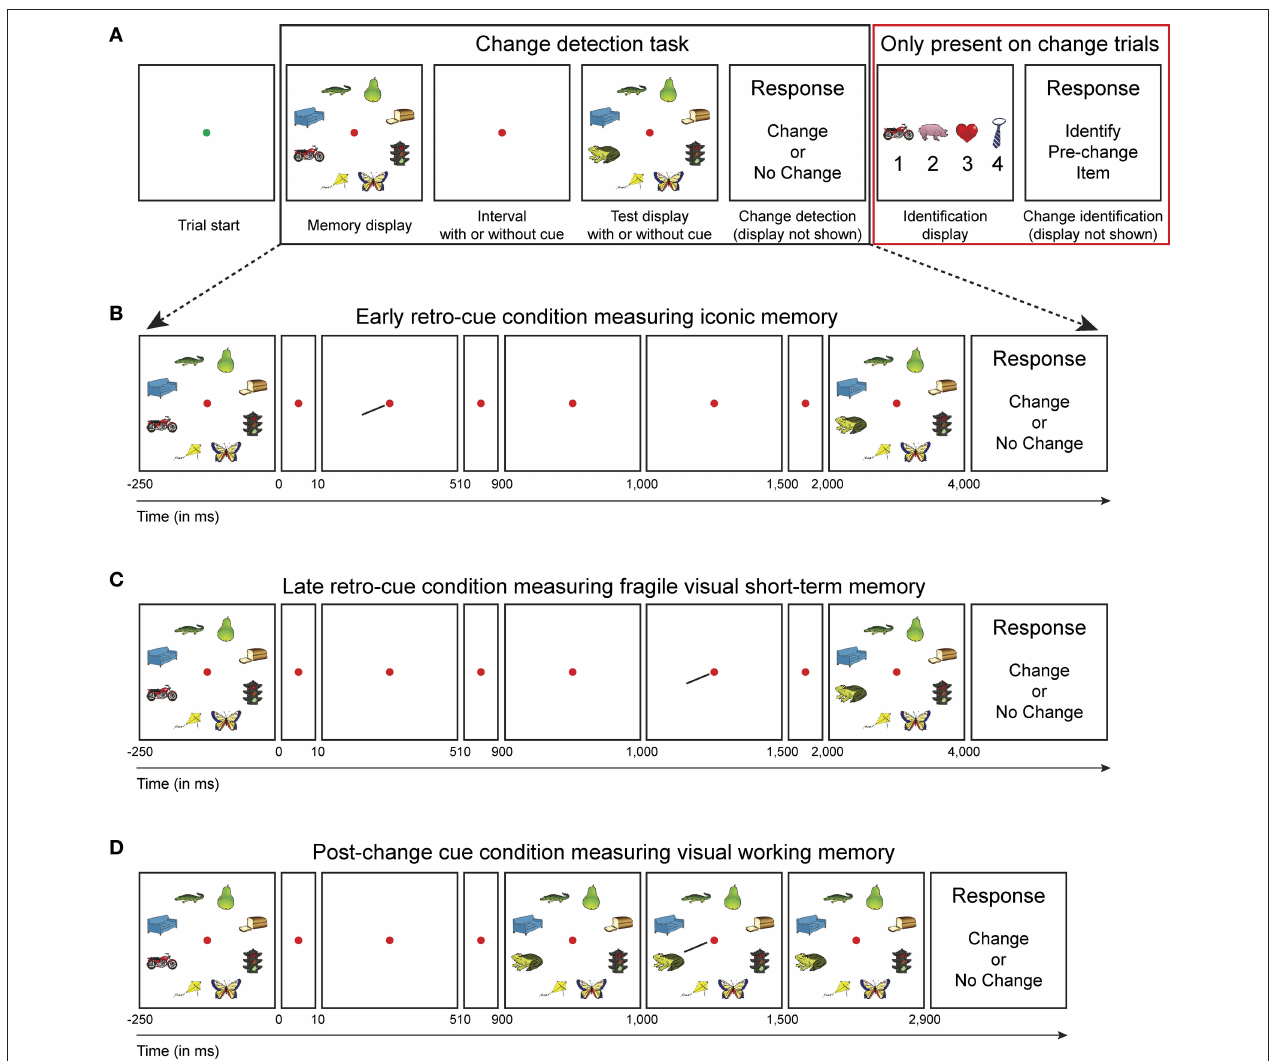
Figure 1 | experimental design. (A) Subjects performed a change detection task to measure the capacity of short-term memory representations (black box). After each change trial, an identification display was presented that contained the item that was present in the memory display, but not anymore in the match display (so-called pre-change item) in addition to three distracter items that were present in neither memory nor test display (red box). We assume that high-resolution representations support both change detection and identification, whereas low-resolution representations support change detection